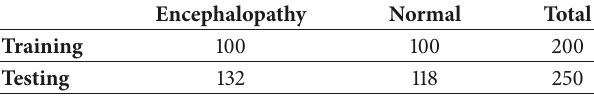
Table 2: Data set for training and testing.